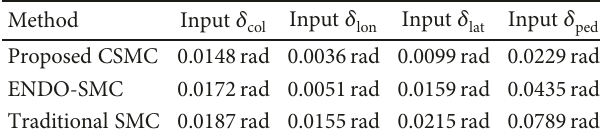
Table 2: The root mean square (RMS) of control